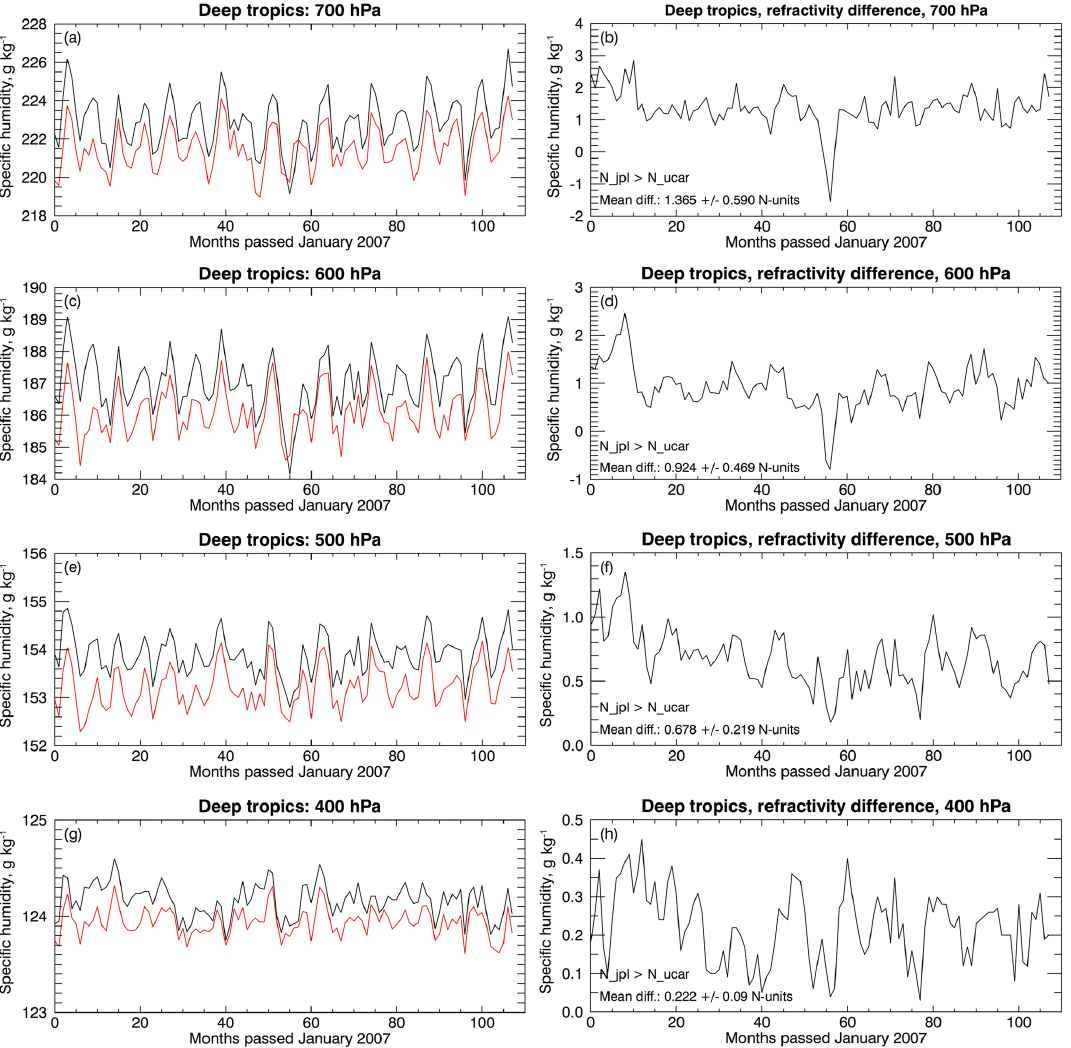
Figure 5. Times series of the monthly zonal averages of the refractivity from 1 January 2007 until 31 December 2015 in the deep tropics ( ± 15 ◦ ) from JPL (black) and UCAR (red) at (a) 700hPa, (b) 600hPa, (c) 500hPa, and (d) 400hPa pressure levels. The time series of the refractivity differences between JPL minus UCAR are shown at (e) 700hPa, (f) 600hPa, (g) 500hPa, and (h)